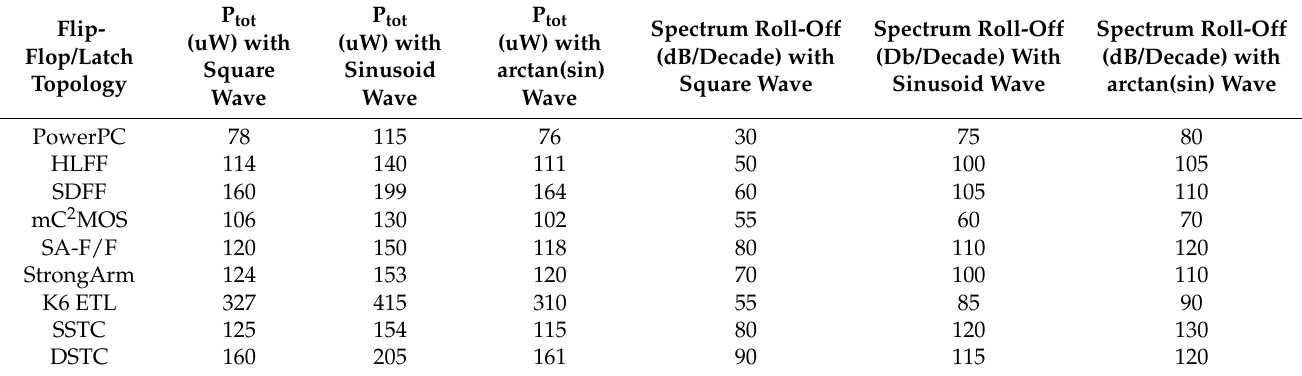
Table 8. Comparison of simulation results using the BSIM3 transistor